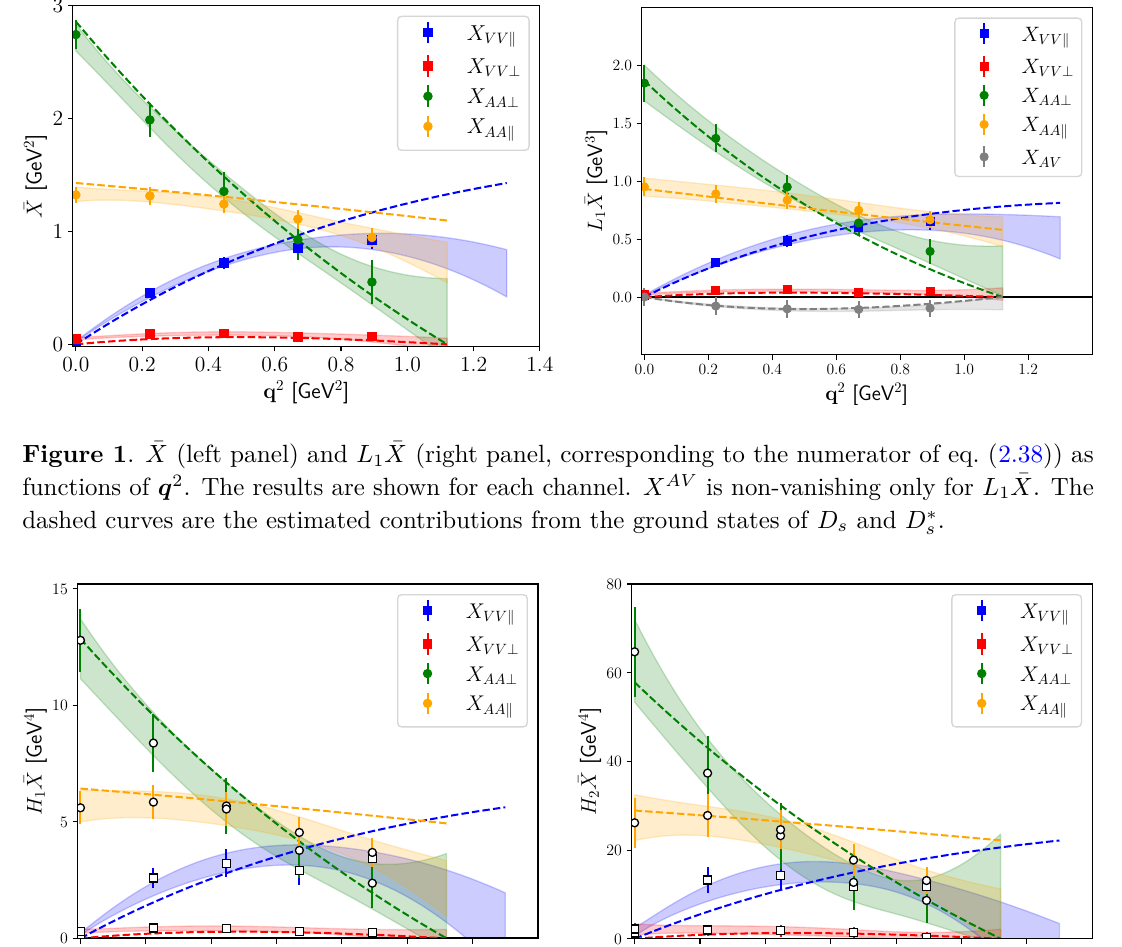
Figure 2 . H 1 ¯ X (left panel) and H 2 ¯ X (right panel), which are numerators of eq. (2.37), as a function of q 2 . The results are shown for each channel. The dashed curves are estimated contributions from the ground state of D and D ∗